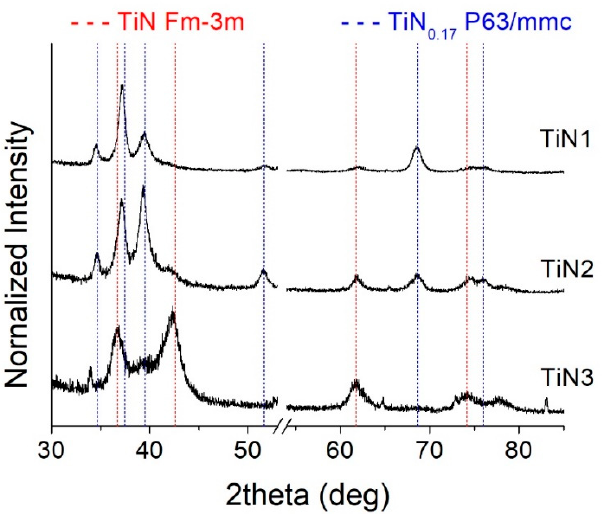
Figure 5. XRD patterns collected from samples TiN1, TiN2, and TiN3, deposited at low nitrogen flow. Instead, TiN2, which was deposited with a nitrogen flow of 1 sccm, shows a biphasic, T = 140 ◦ C) appears to consist almost entirely of hexagonal phase, missing the signals with a difference in the presence of nitrogen diffused within the reticule. The solubility